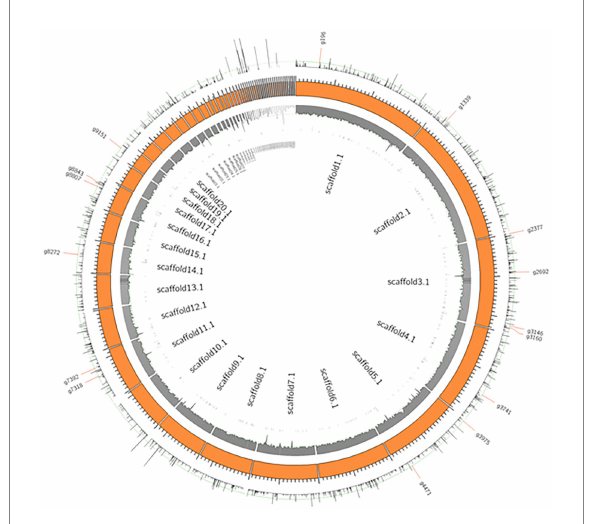
FIGURE 5 Genome wide SNVs of PO212 genome against S27. Orange boxes present scaffolds of the PO212 genome. The first inner track, the gray histogram, shows the coverage of the S27 reads aligned against the PO212 genome. The data show full coverage of the PO212 genome. The outermost track represents the SNV density of the PO212 genome against the aligned S27 reads. The innermost track, black ticks, represents genes containing SNVs in their coding region. 15 genes are highlighted with longer ticks in the innermost track and labeled in the outermost track. These 15 genes showed 100% allelic variation on the SNV loci of PO212 when compared with S27.